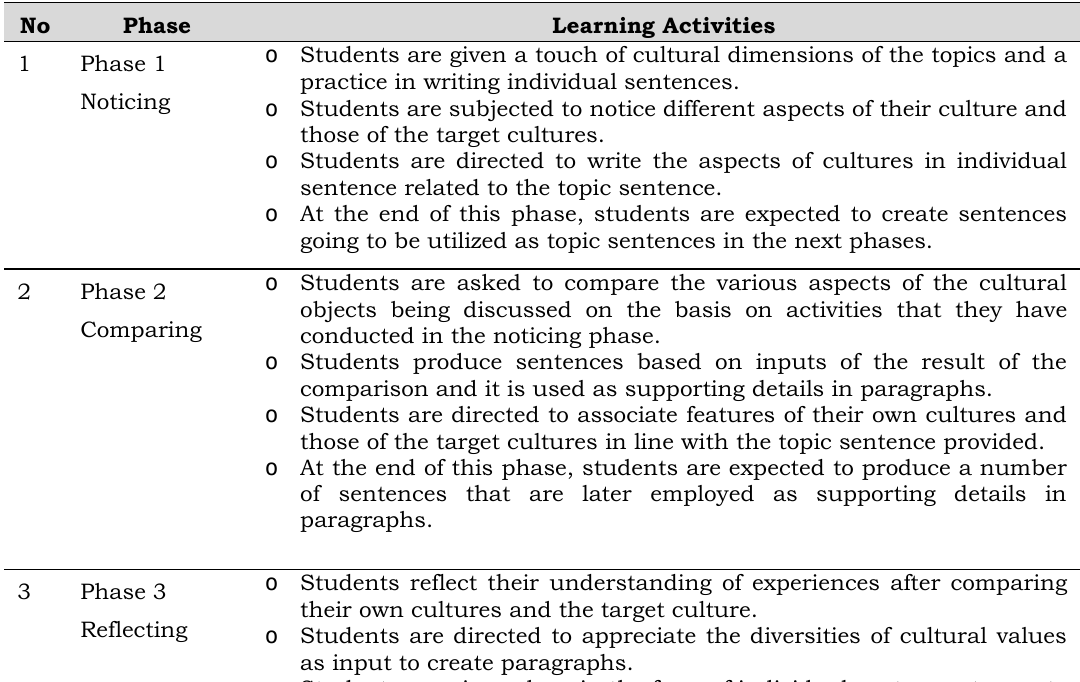
Table 2. The developed instructional model for writing